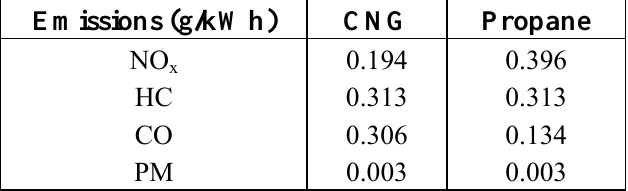
Table 15. Emissions from the Capstone C30HEV